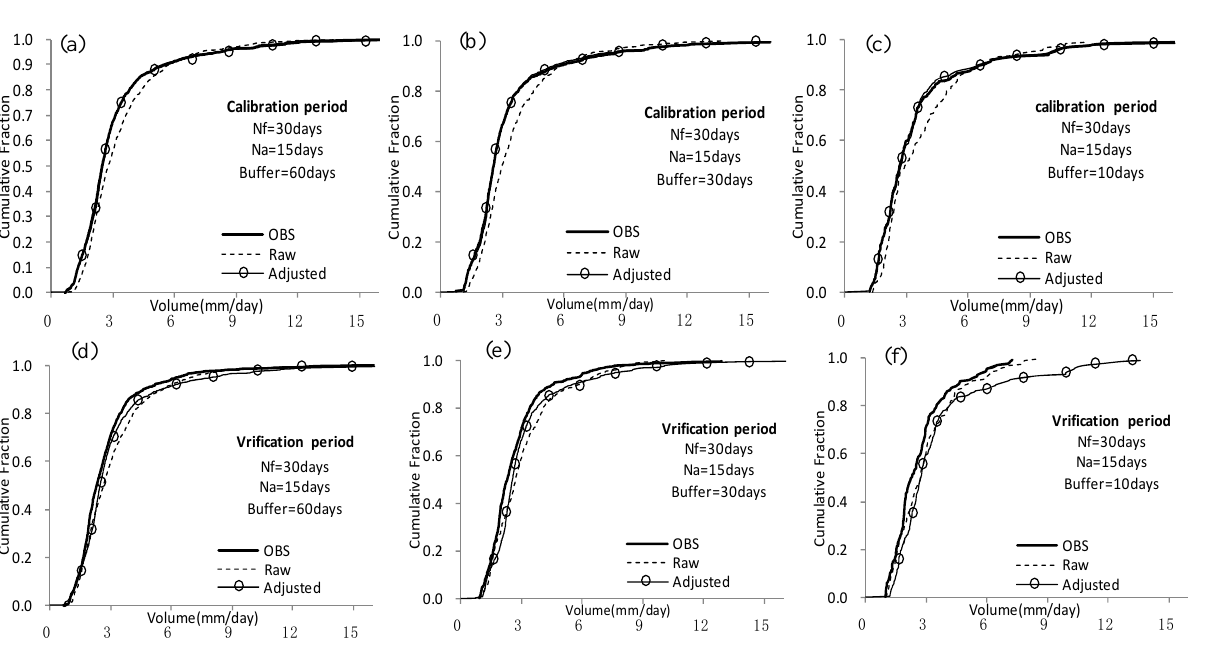
Fig. 7. The effects of buffer period lengths on GLMPP